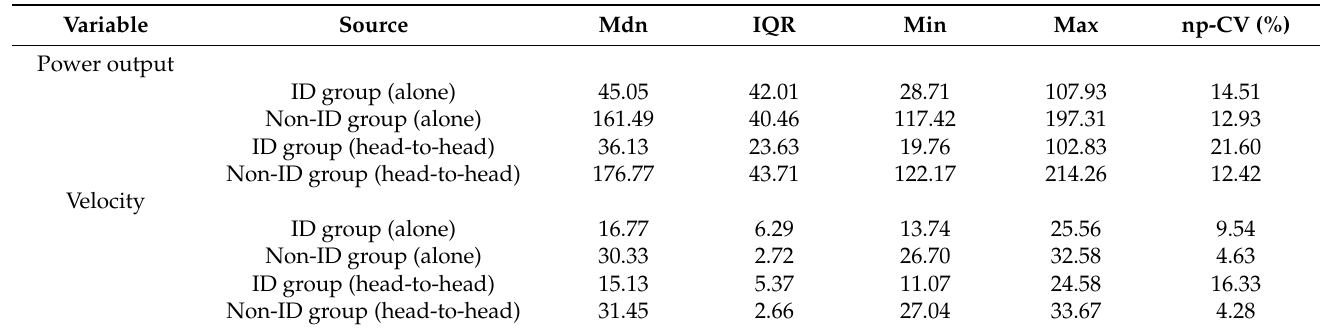
Table 1. Descriptive statistics of power output (Watts) and velocity (km/h) for the ID and non-ID groups in the ‘alone’ and ‘head-to-head’ condition